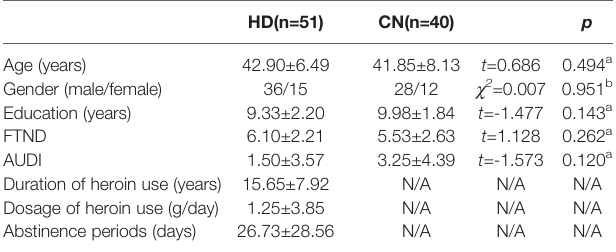
TABLE 1 | Demographic information and